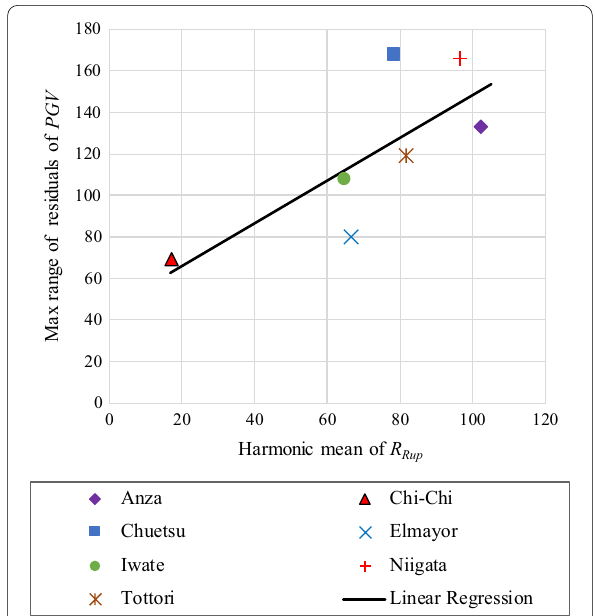
Fig. 7 Max range of the residuals of the PGV versus the harmonic mean of R RUP of record stations of different